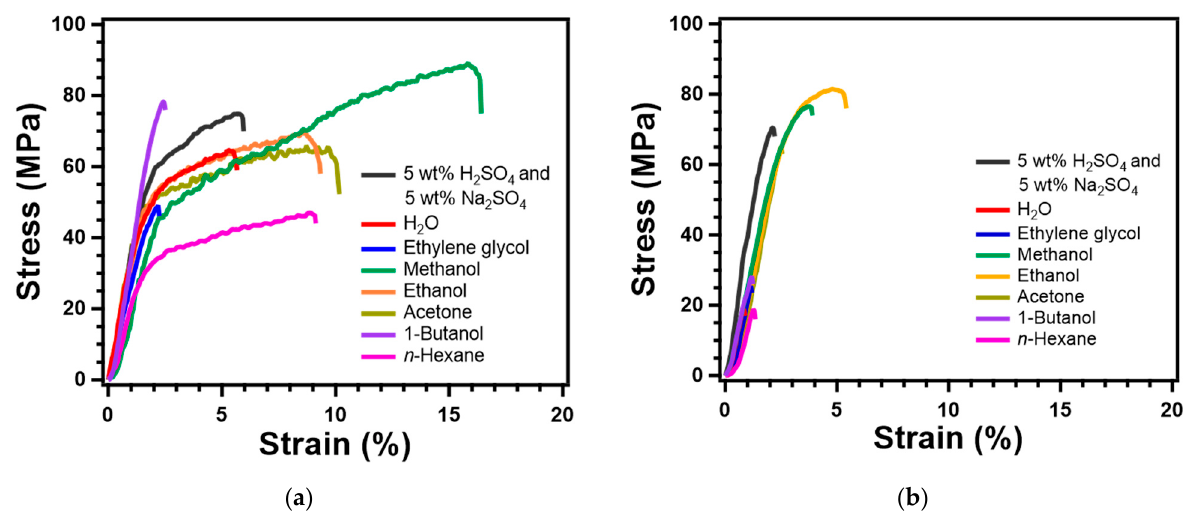
Figure 6. Stress ‐ strain curves of regenerated cellulose films prepared from ( a ) CNF and ( b ) MCC through coagulation with various solvents.